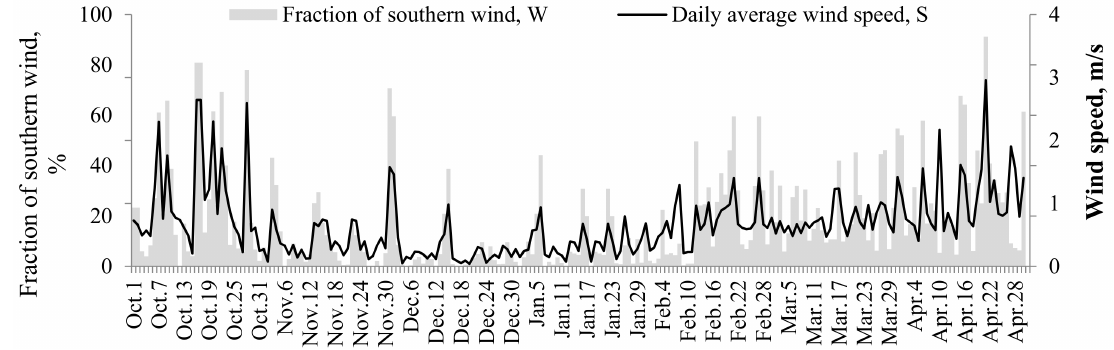
Figure 5. Daily average wind speed and daily fraction of the southern